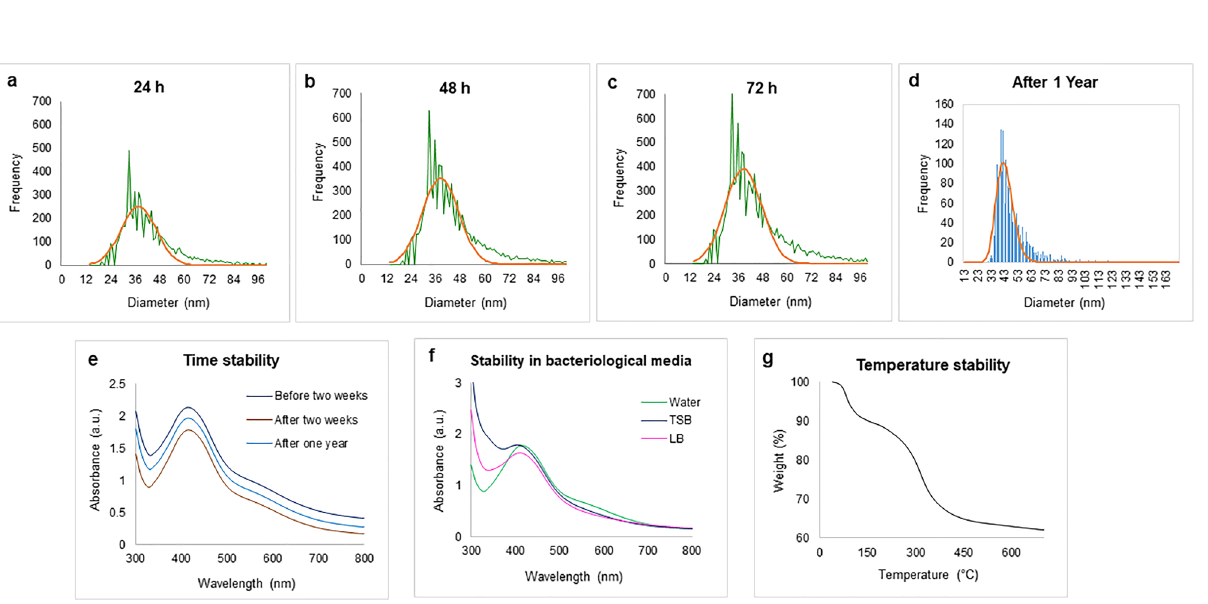
Figure 6. Inductively coupled plasma-mass spectrometry measurement of AgNPs, which shows the size distribution histogram. ( a ) ICP-MS measurement of AgNPs after 24 h, ( b ) 48 h, ( c ) 72 h ( d ) and one year of NPs formation (the green color shows the frequency of size distribution, and the orange line is the mean value). UV/ Vis spectra for nanoparticles ( e ) time-dependent stability at a difference of two weeks and one-year ( f ) stability of AgNPs in bacteriological media. ( g ) Thermogravimetric analysis of NPsin the range of temperature 0–700 ℃